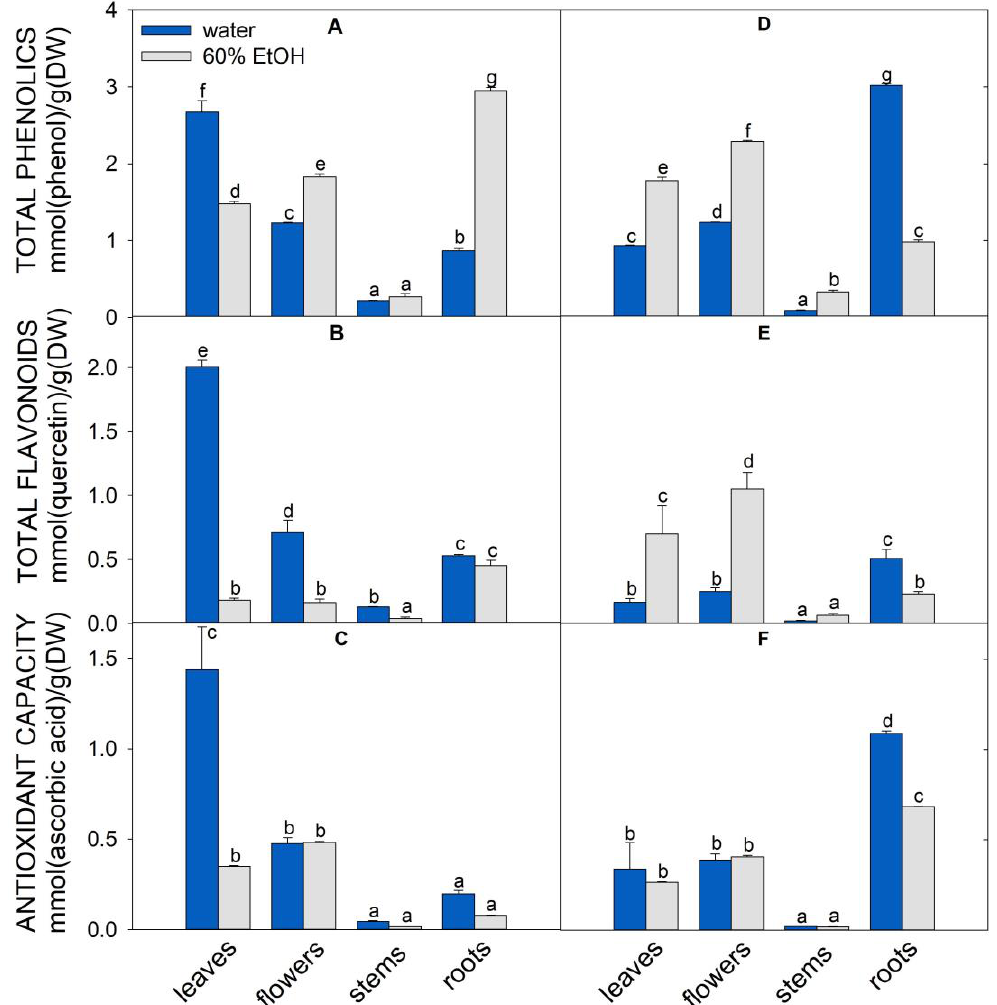
Figure 1. Characterization of A. eupatoria ( A – C ) and O. vulgare ( D – F ) extracts prepared in water (blue columns) or 60% ethanol (gray columns). Total phenolics ( A , D ), total flavonoids ( B , E ), antiox- idant capacity determined by FRAP assay ( C , F ). The quantity is expressed as mmol per gram of dry plant matter. The values show the mean ± SD (n = 3 biological series). Letters above each bar denote significant differences ( p ≤ 0.05) among the groups according to ANOVA (Holm – Sidak